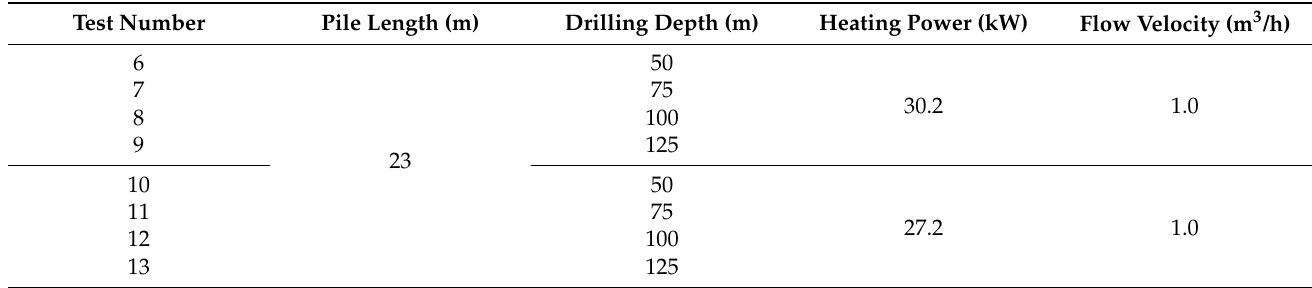
Table 3. Heat exchange simulation test plan of energy